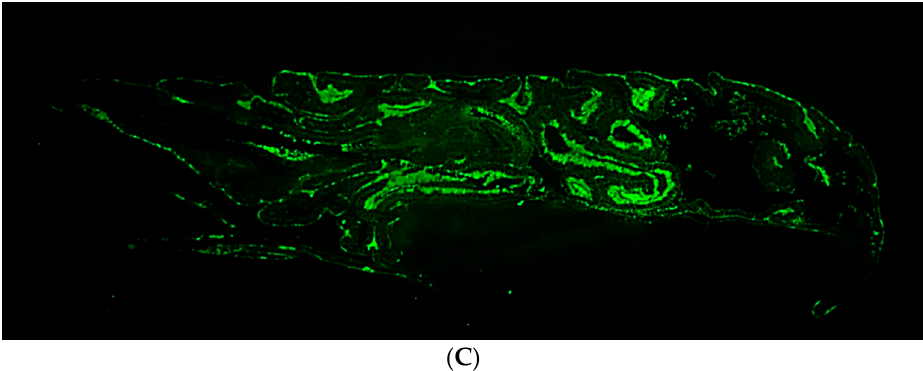
Figure 3. Example of immunohistochemical staining, ( A ) aSMA, ( B ) HE, ( C ) CD 105. Magnification: 2-fold.